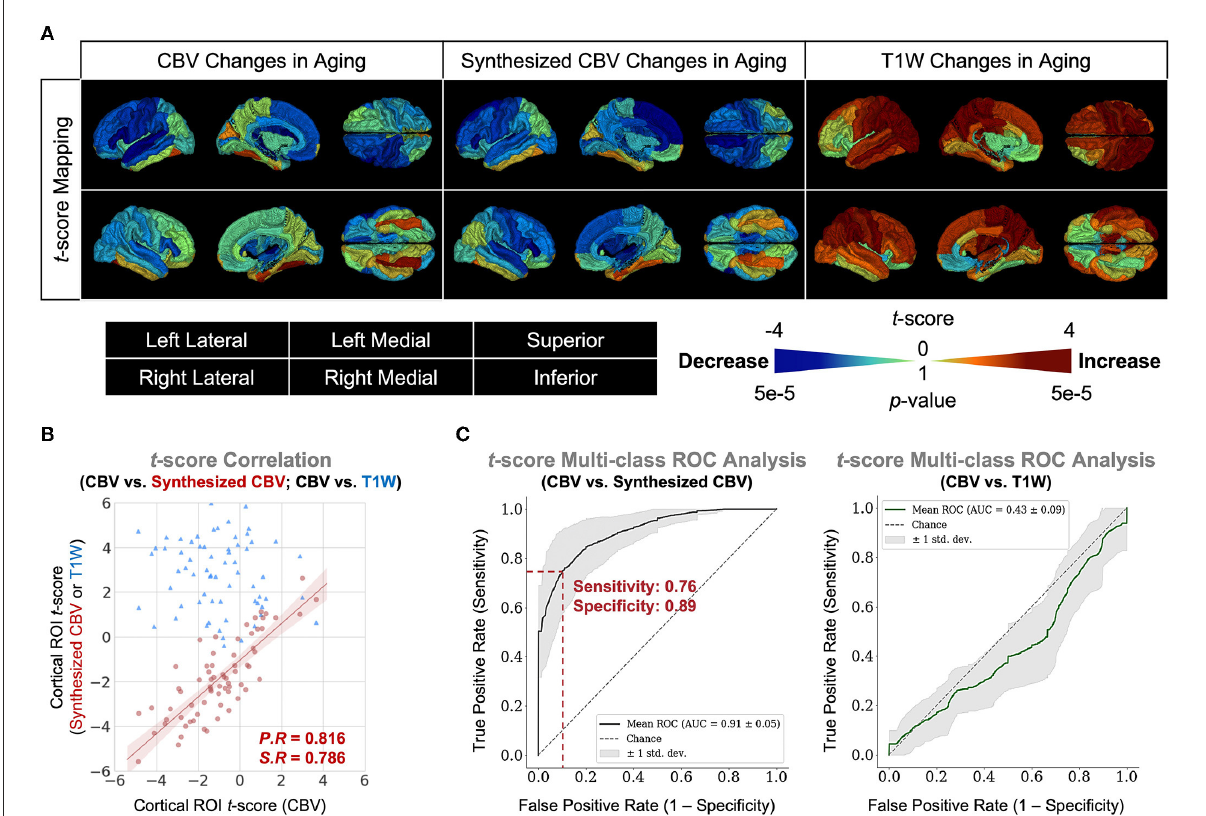
FIGURE6 DeepContrast maps age-related changes over the entire cortex. (A) Three-dimensional volume rendering of the age-related t -score maps over the 72 FreeSurfer cortical region-of-interests (ROIs) reveals that the age-related changes in the synthesized CBV maps is similar to those in the ground truth CBV maps, despite that the non-contrast T1W scans which serves as the input to the DeepContrast model does not share either the same or the opposite trends. (B) A scatter plot of the age-related t -score over the 72 ROIs demonstrates that the age-related changes in synthesized CBV are consistent to those in CBV (P.R = 0.816, S.R = 0.786) while the T1W counterparts do not (P.R = –0.131, S.R = –0.122). (C) An analysis of the concordance to CBV t -scores by treating it as a 1,000-class classification problem reveals that age-related changes